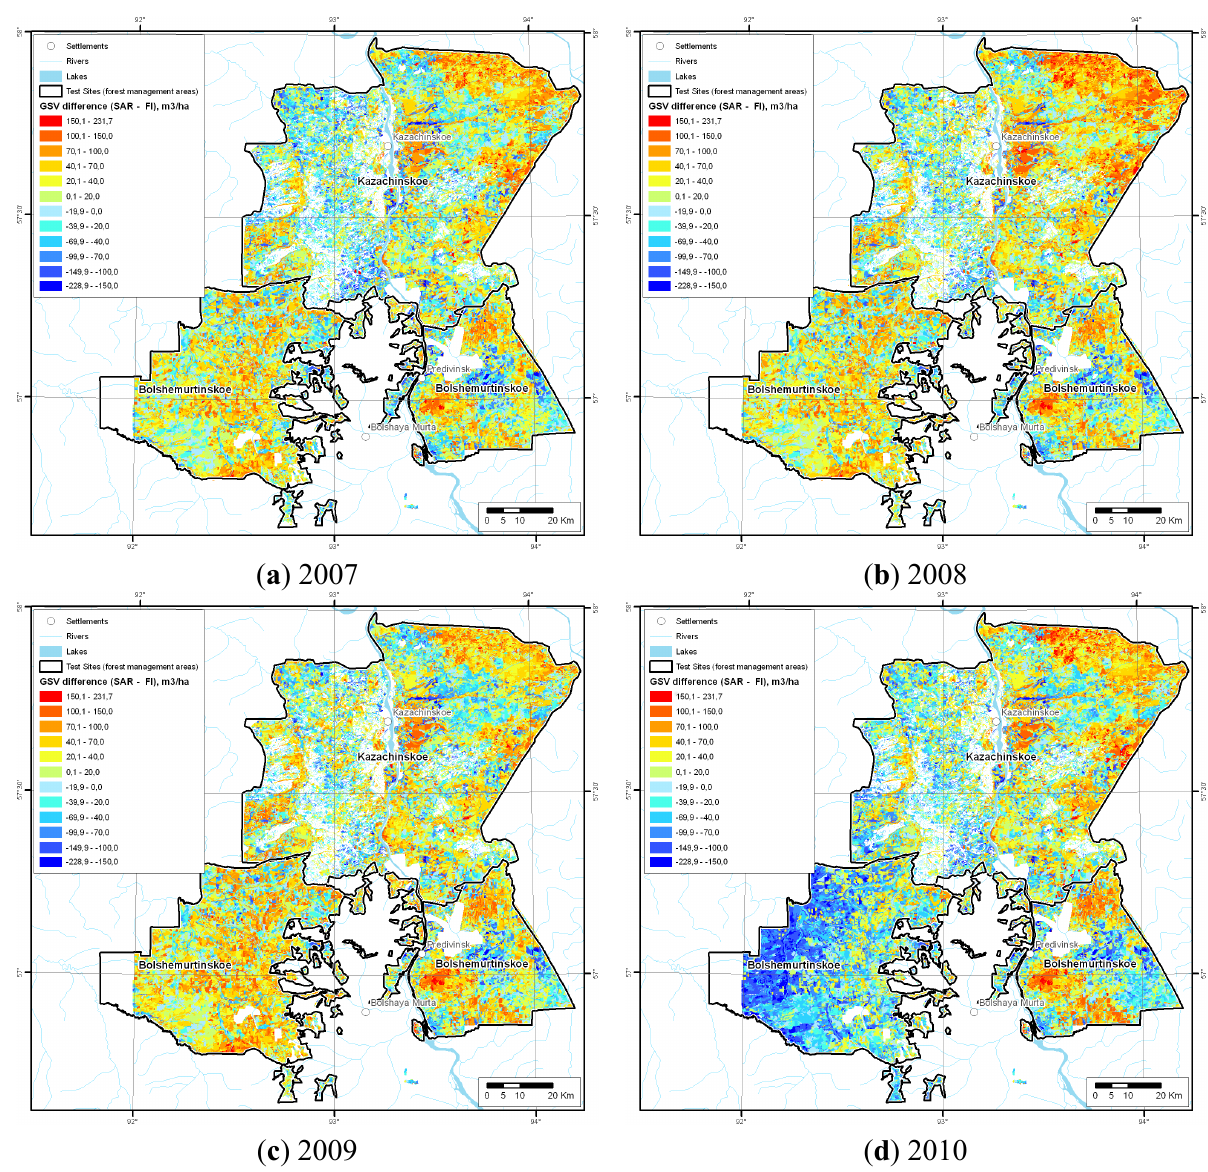
Figure 7. GSV difference between SAR-derived and FI GSV for the validation sites, Kazachinskoe and Bolshemurtinskoe. ( a ) 2007; ( b ) 2008; ( c ) 2009; ( d ) 2010.